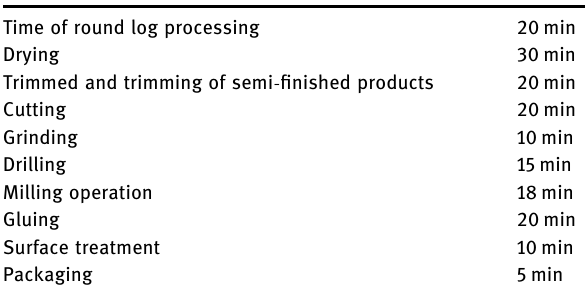
Table 1: Times of production